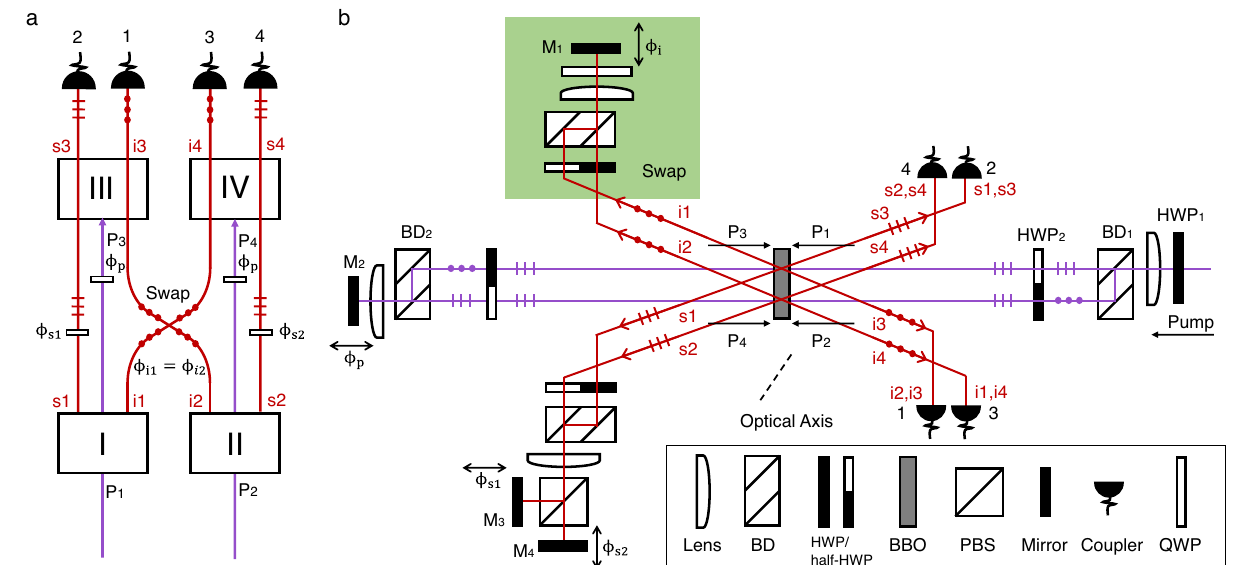
Fig. 2| Four-photonfrustratedinterference. a Scheme of frustrated four-photon interference. Four-fold coincidence events occur when crystals I and II, or crystals III and IV generate two pairs of photons simultaneously. ϕ sX and ϕ iX represent the phaseofthesignalandidlerphotonfromcrystalX,respectively,and ϕ p isthephase ofthepumps.Theinterferencepatternemergeswhenwecannotdistinguishwhich group the four photons come from. The quantum state is given by (cid:1) ∣ ψ = ½ e i ð ϕ i 1 + ϕ s 1 + ϕ i 2 + ϕ s 2 Þ + e i 2 ϕ p (cid:2) ∣ 1111 i , which is a product state and has no entangle- ment. b Experimentalsetup.Thepumpincidentsfromtherightsideandsplitsona